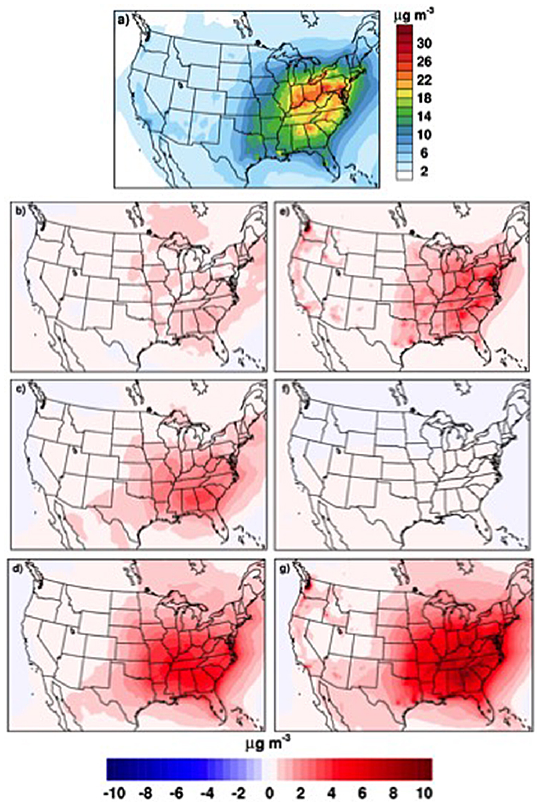
Figure 13. (a) Current decade base case PM 2 . 5 average concen- trations for five summers in the 2000s; and spatial distribution and regional effect on PM 2 . 5 due to (b) changes in meteorology (Sim- ulation 1–Simulation 0); (c) changes in meteorology and biogenic emissions (Simulation 2–Simulation 0); (d) changes in meteorol- ogy, biogenic emissions, and land use (Simulation 3–Simulation 0); (e) changes in US anthropogenic emissions (Simulation 4– Simulation 0); (f) changes in global anthropogenic emissions (Sim- ulation 5–Simulation 0); and (g) all the changes above combined (Simulation 6–Simulation